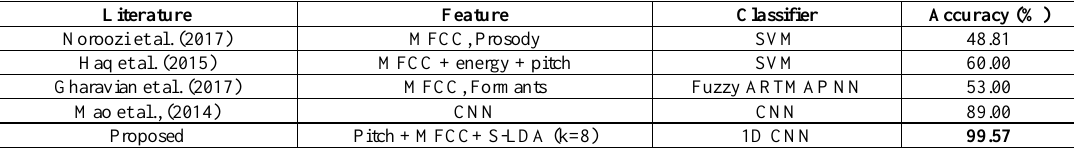
Table 7. Performance comparison of present work with the state of the art methods for SAVEE